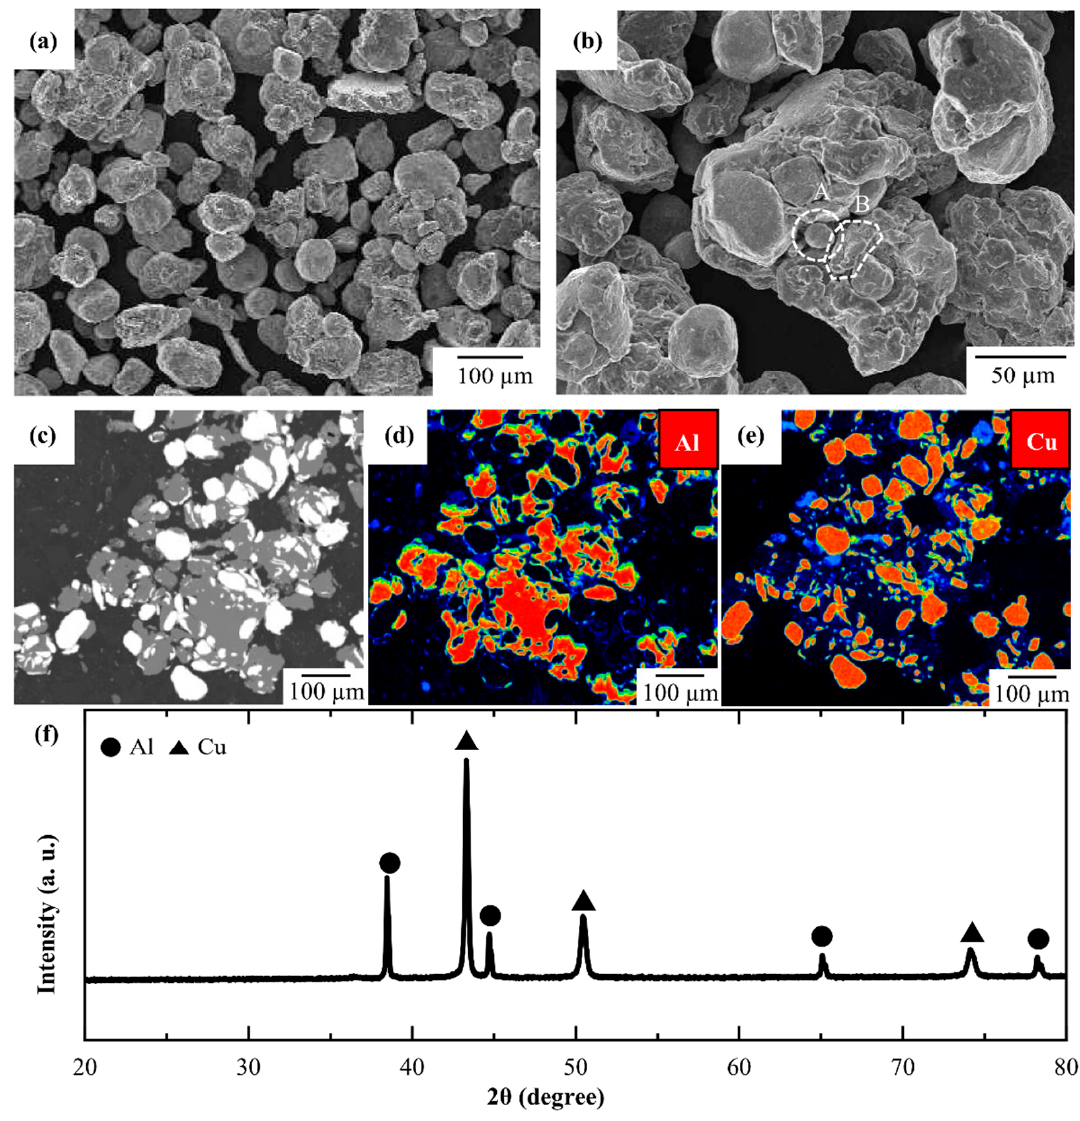
Figure 1. FE-SEM image of ( a ) Al–Cu powder prepared by ball milling and ( b ) high-magnification image of ( a ) with particles A and B labelled by dashed lines; ( c ) back scattered compositional image of Al–Cu powder; ( d , e ) FE-EPMA elemental mapping images for elements Al ( d ) and Cu ( e ); ( f ) XRD profile of Al–Cu powder.